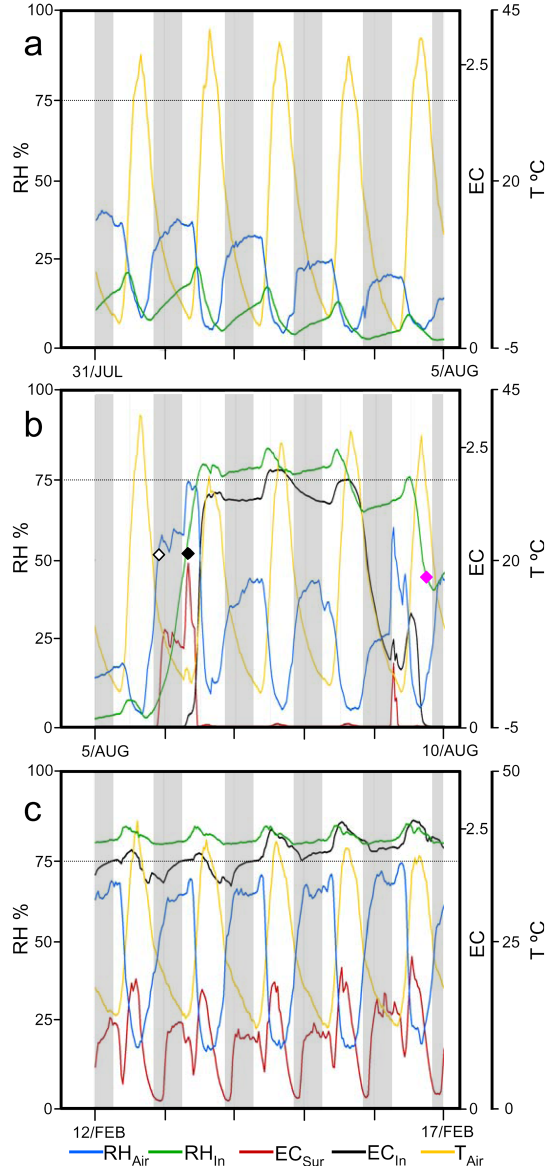
Fig. 3. Moisture conditions inside and outside the halite pinnacles. Grey vertical stripes indicate nighttime dark hours. (a) Dry stage when RH Air and RH In fall below 40% and 25% respectively, and EC sensors record null values. (b) Short wet event. Water conden- sation occurs first on the halite surface (white diamond), and is fol- lowed several hours later by capillary condensation in the coloniza- tion zone (black diamond); the pinnacle falls back to the dry stage after four days of wet internal conditions (pink diamond). (c) Por- tion of a 40-day-long wet stage, when RH In is continuously above 75%. Concurrently, RH Air oscillates between 17–19% (afternoons) and 70–74% (nights and dawn). Positive EC values indicate liquid water inside the pinnacles and on their surface. Note that the max- imum EC Sur value was observed between 1 and 3p.m., at lowest RH Air and highest daily T Air . RH Air = atmospheric RH; T Air = at- mospheric T ; RH In = RH in halite interior; EC Sur = conductivity on halite surface; EC In = conductivity in halite